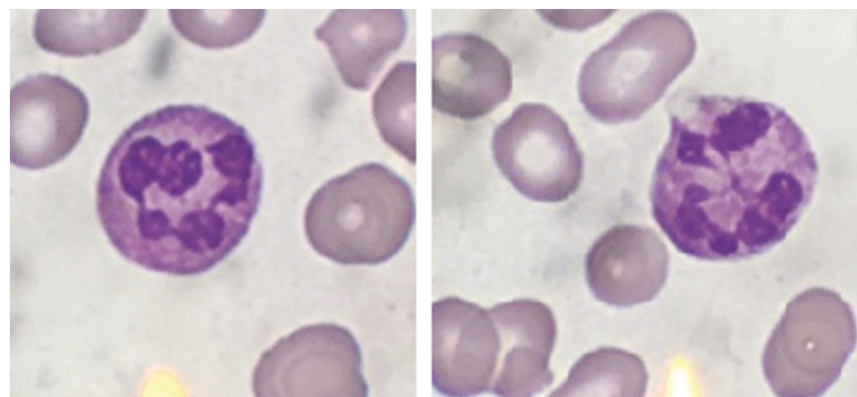
Figure 4: Magnified view of hypersegmented neutrophils.